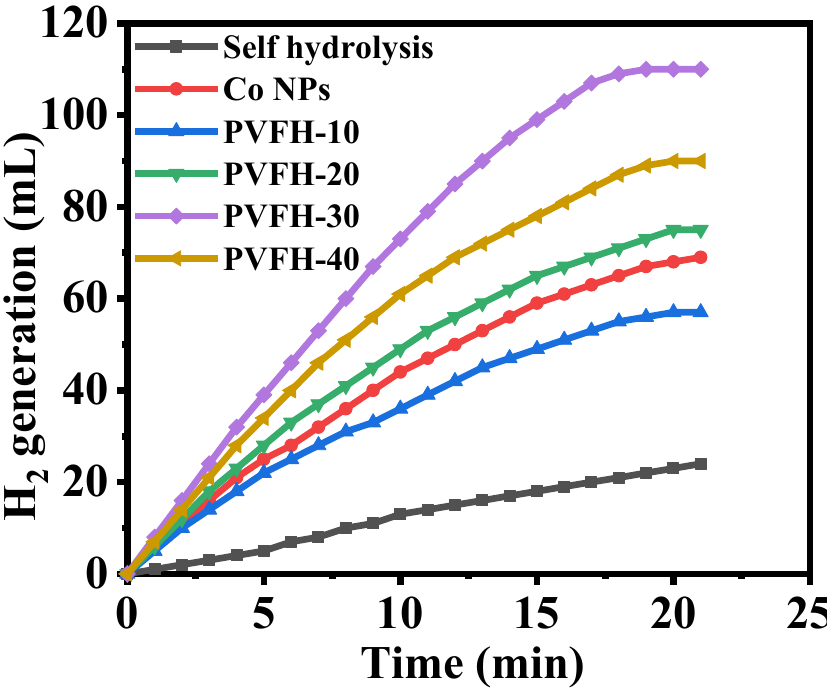
Figure 7. The influence of Co@PVHF membranes on the dehydrogenation of SBH. The amount of catalyst = 100 mg, [SBH] = 1 mmol, and T = 298 K.